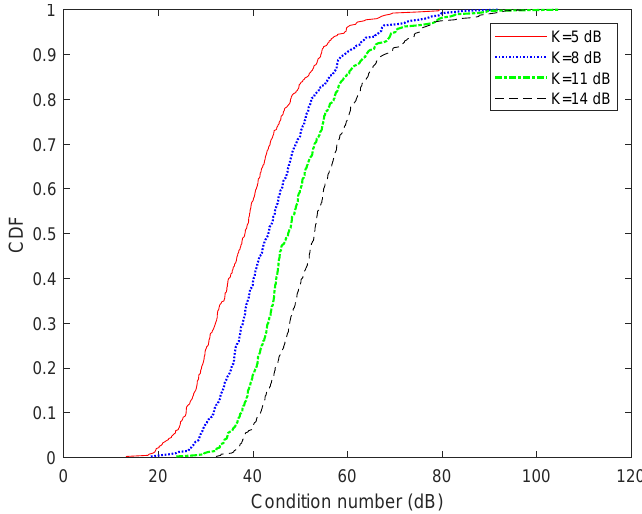
Figure 6. The effect of the Rician K-factor on CN—2T2R (LCXs on the far side).